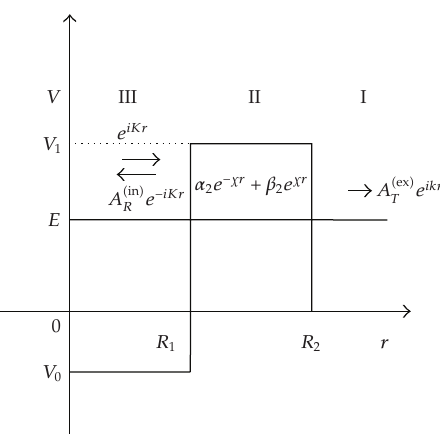
Figure 10: Schematic view of the second phase of the scattering process, the emission from